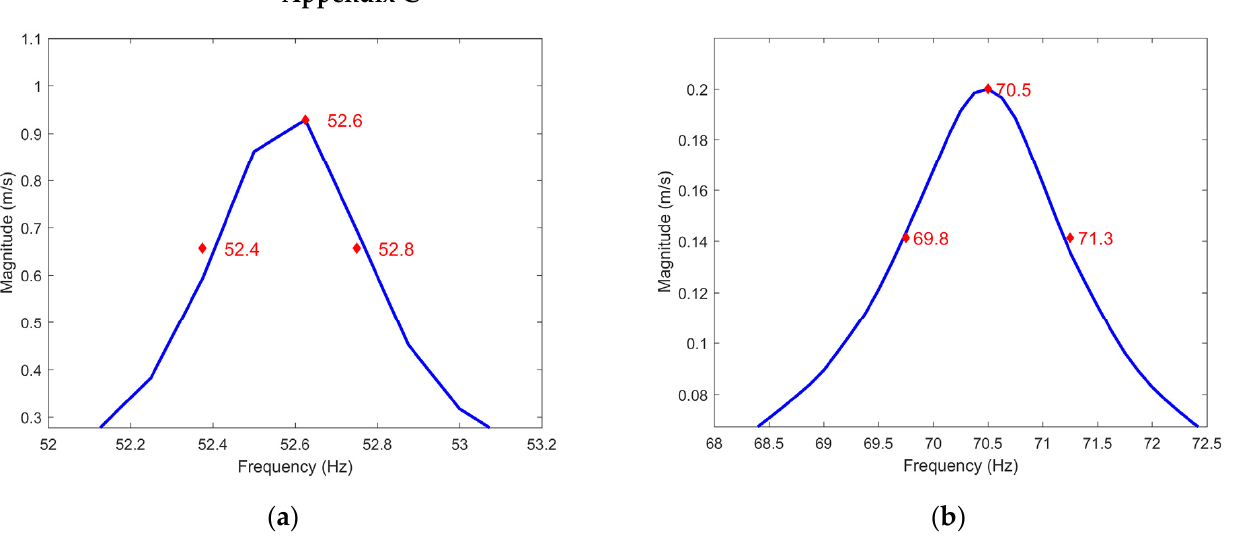
Figure A2. The half-bandwidth method for modal loss factor extraction for ( a ) the first mode and ( b ) the second mode (see Table 2 for details).